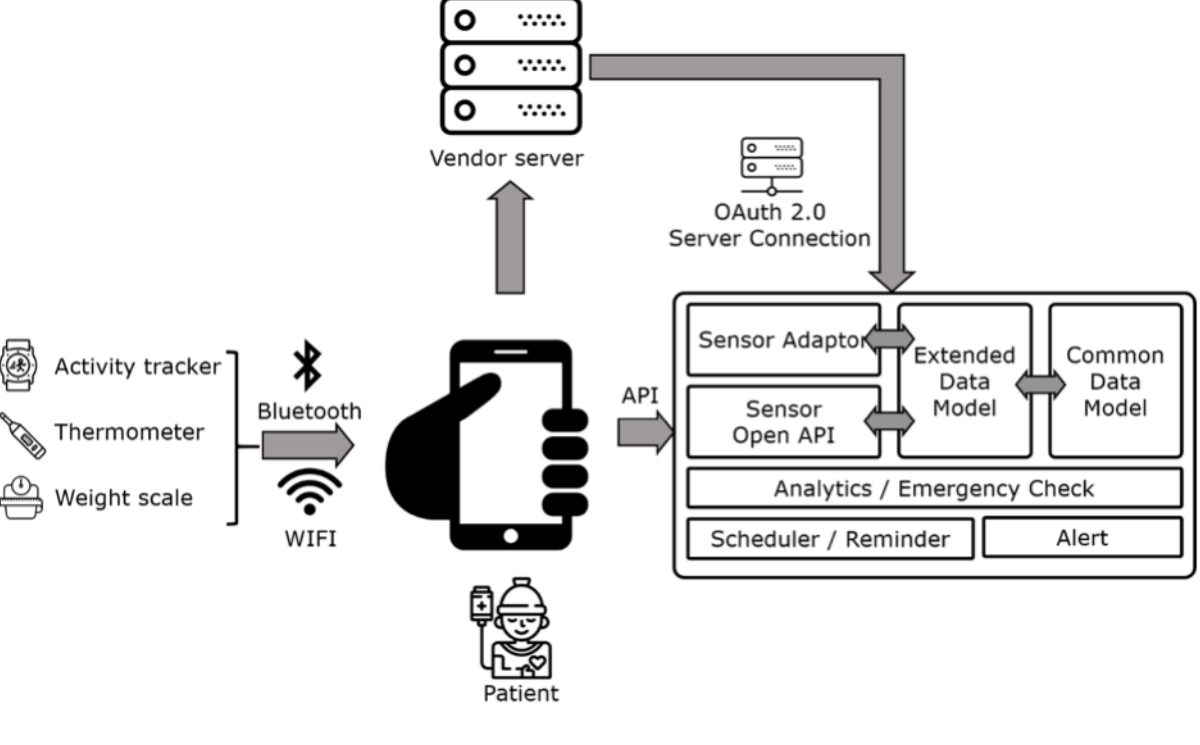
Figure 2. System architecture of Life Manager. Data from patients were collected through the app and processed with predesigned rules. API: application programming